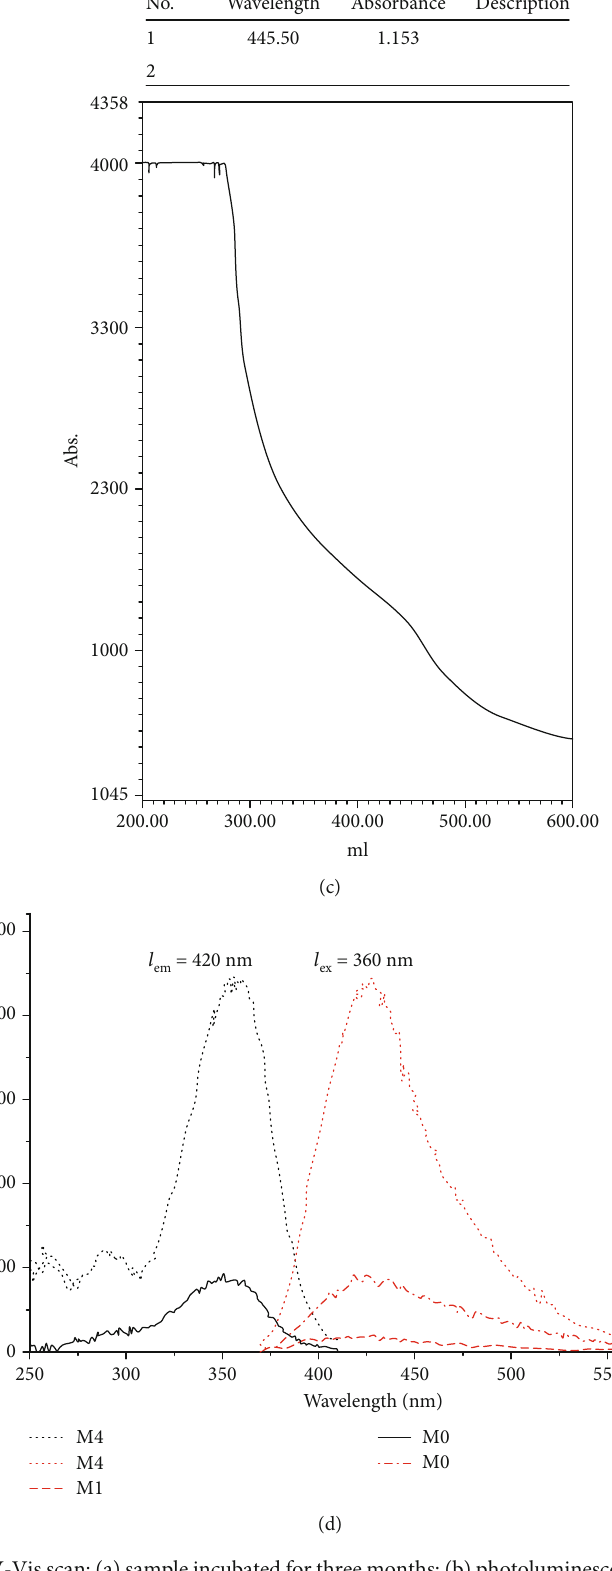
Figure 1: (a – c) Graphs of the UV-Vis scan: (a) sample incubated for three months; (b) photoluminescence spectra (c) of the cadmium sul fi de nanoparticle biosynthesized by Aspergillus niger (RCMB 002002). (d) The surface plasmon excitation bands for cadmium sul fi de nanoparticle biosynthesized by Aspergillus niger (RCMB